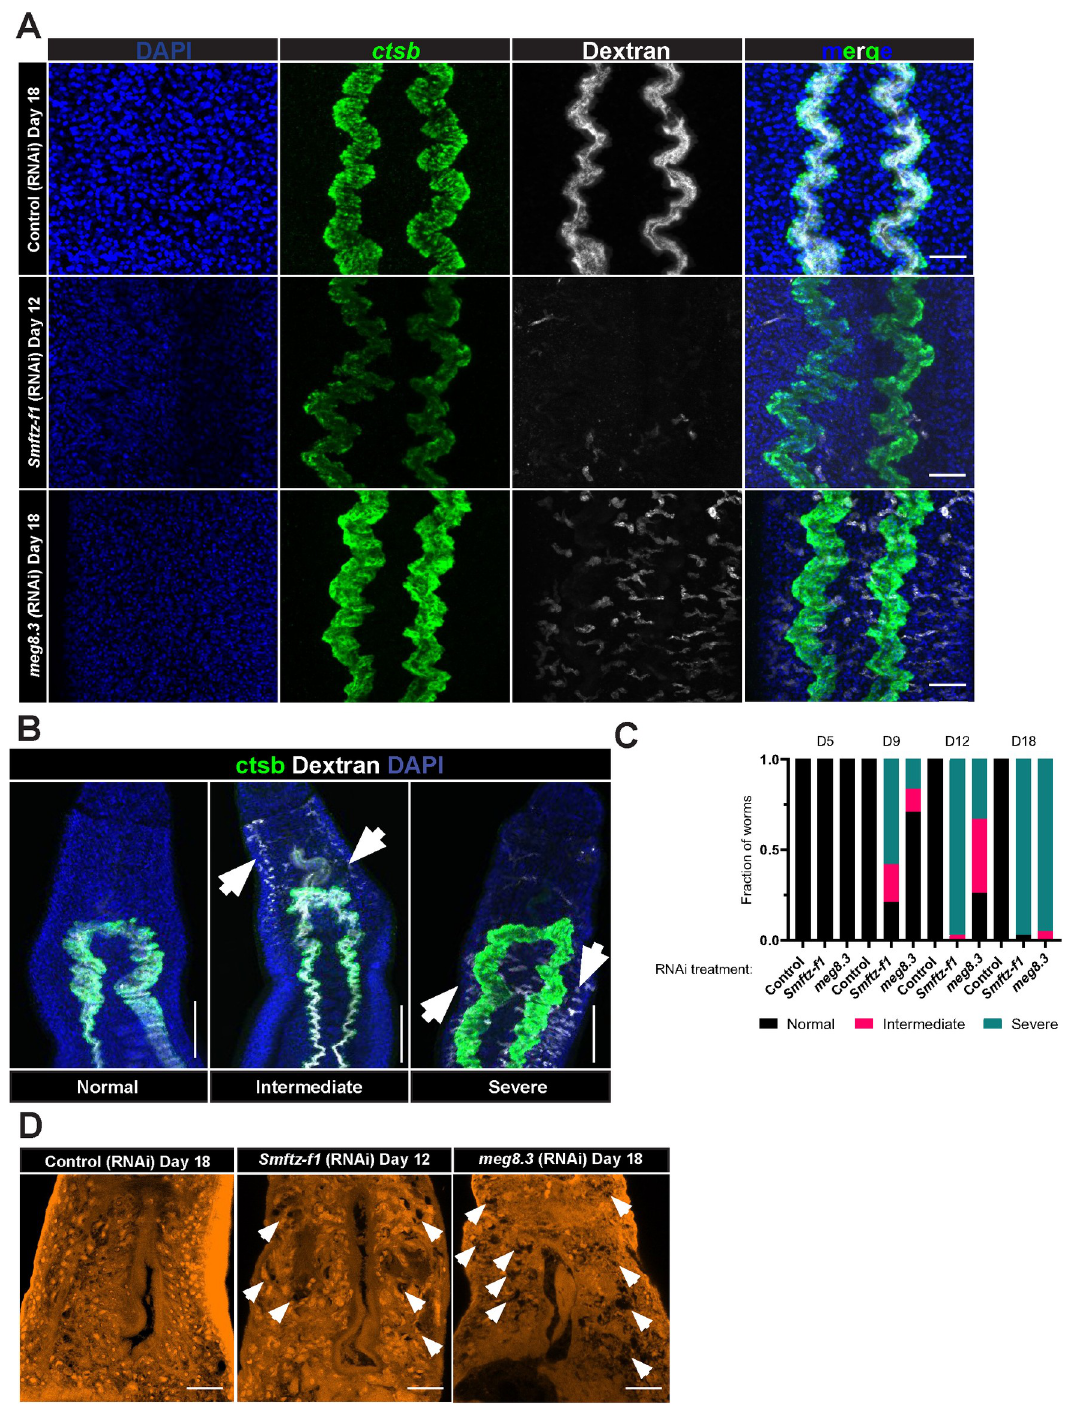
Fig 4. meg-8 . 3 is essential for esophageal gland tissue maintenance. (A) FISH of the gut marker ctsb (green), and fluorescent dextran (white) in the heads of control(RNAi), Smftz-f1(RNAi) and meg-8 . 3(RNAi) animals. Representative of > 10 animals from 3 experiments (B) Three distinct phenotypic severities are observed following RNAi: Normal, Intermediate, and Severe. Normal animals possess an intact and well-organized gut as observed by ctsb expression and fluorescent dextran in lumen of the gut. Intermediate animals have normal gut structure and possess fluorescent dextran in the gut, but also contain dextran collecting in the protonephridial system in the head (arrows). Severe animals possess a relatively normal gut structure and very little, if any, dextran labeling in the gut. Instead, dextran labeling is found in the protonephridial system (see arrows). (C) Plots depicting the